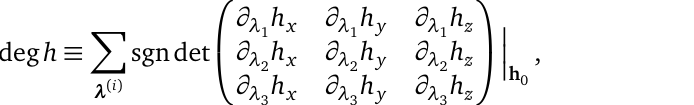
of a surface S h ( 1 ) ( 2 ) ( 3 ) . The points λ , λ and λ are examples 0